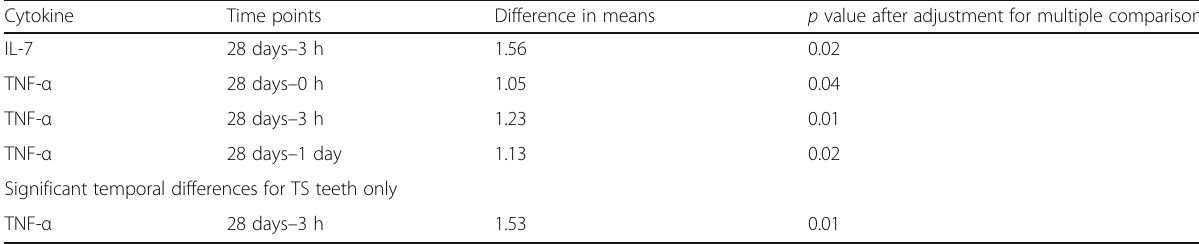
Table 2 Significant temporal differences as based on post hoc analysis of ANOVA results using Tukey ’ s Honest Significant